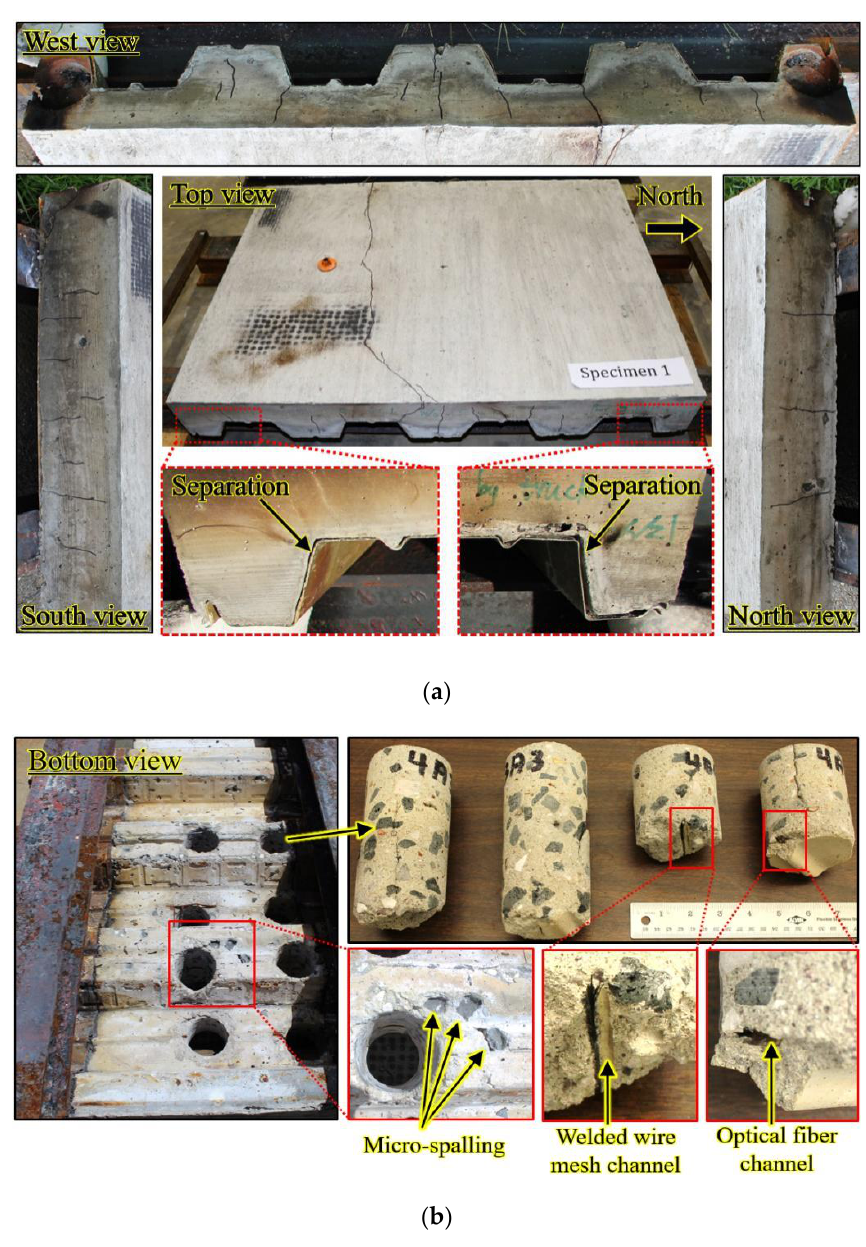
Figure 6. Photograph of CS-1 after fire test: ( a ) before removal of the steel deck, and ( b ) after removal of the metal decking at the bottom of the reinforced concrete slab.